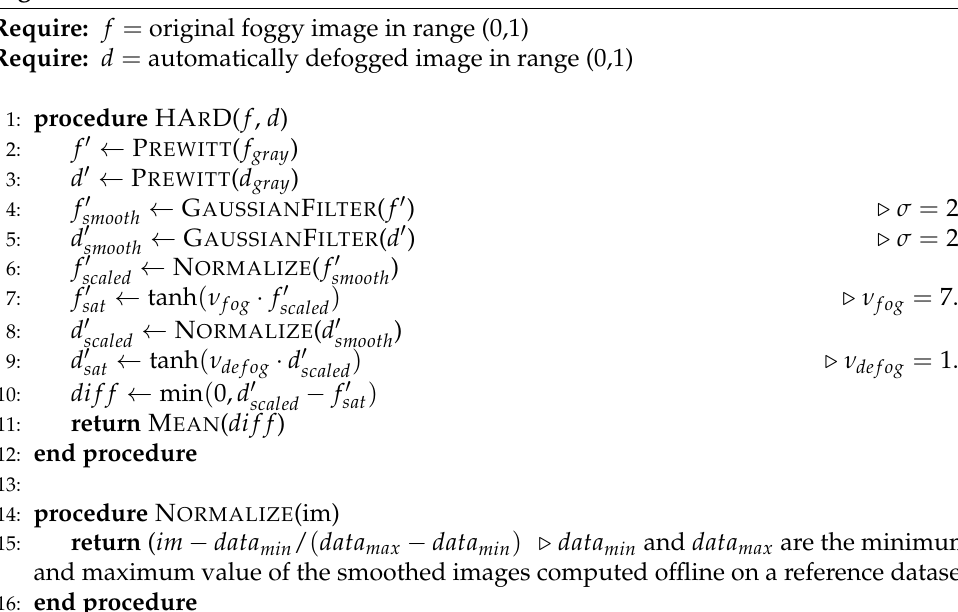
Algorithm 2 HArD metric